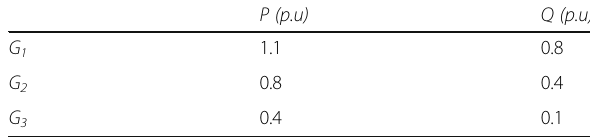
Table 2 Operating conditions of case